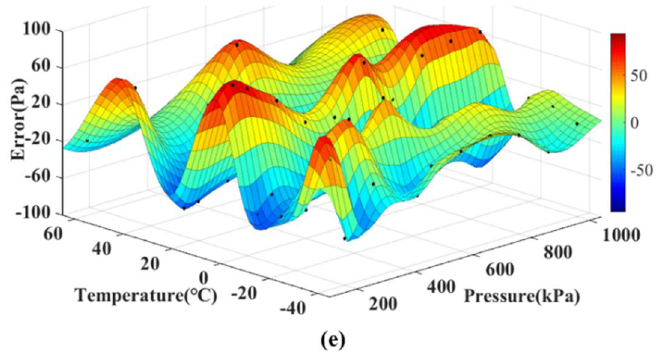
Figure 7. Characterization results: (a) Schematic of the self-oscillation system including an amplifier module, a drive buffer module and an automatic gain control (AGC) circuit; (b) Pressure sensitivities of the sensors with the pressure varying from 100 kPa to 1000 kPa at room temperature; (c) Differential pressure sensitivities of four pressure sensors, indicating a nonlinearity of 0.01% within the pressure range of 100 kPa to 1000 kPa; (d) Temperature sensitivity of the pressure sensor with different caps under an applied pressure of 100kPa; (e) Fitting errors of the proposed sensor within the full pressure range of 100 kPa to 1000 kPa and temperature range of -45°C to 65°C.